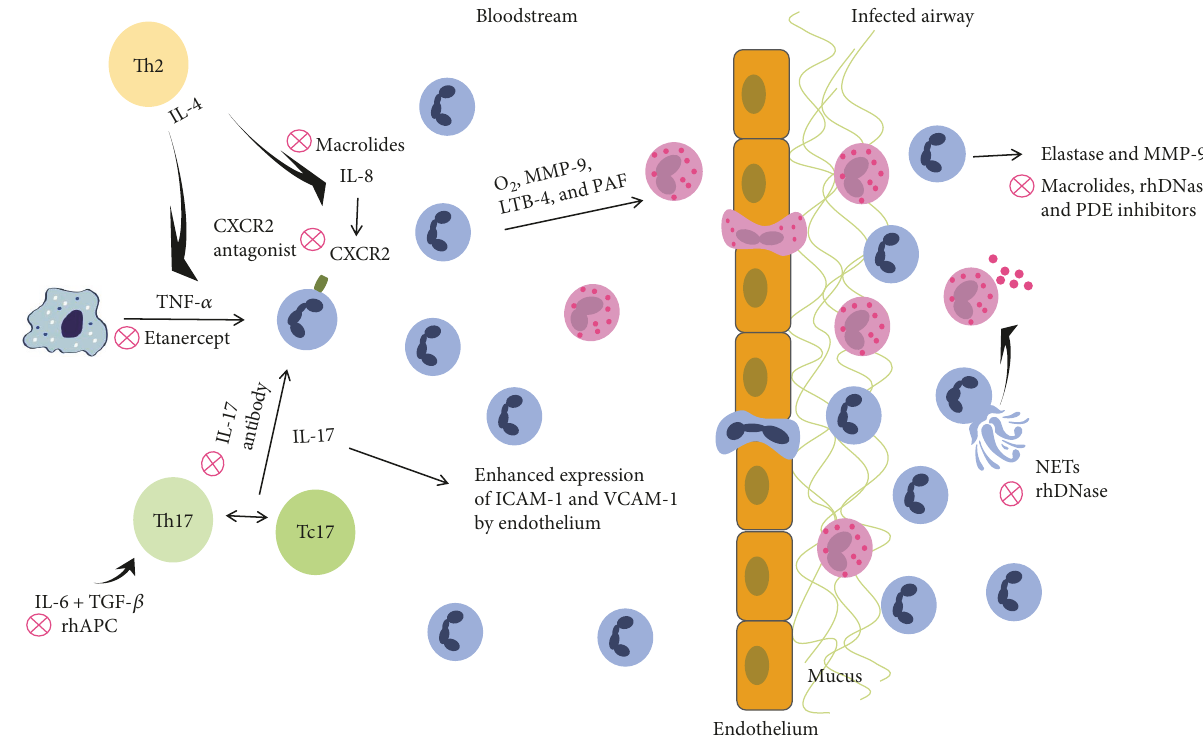
Figure 1: Schematic demonstration of neutrophil migration and in fi ltration in allergic in fl ammatory